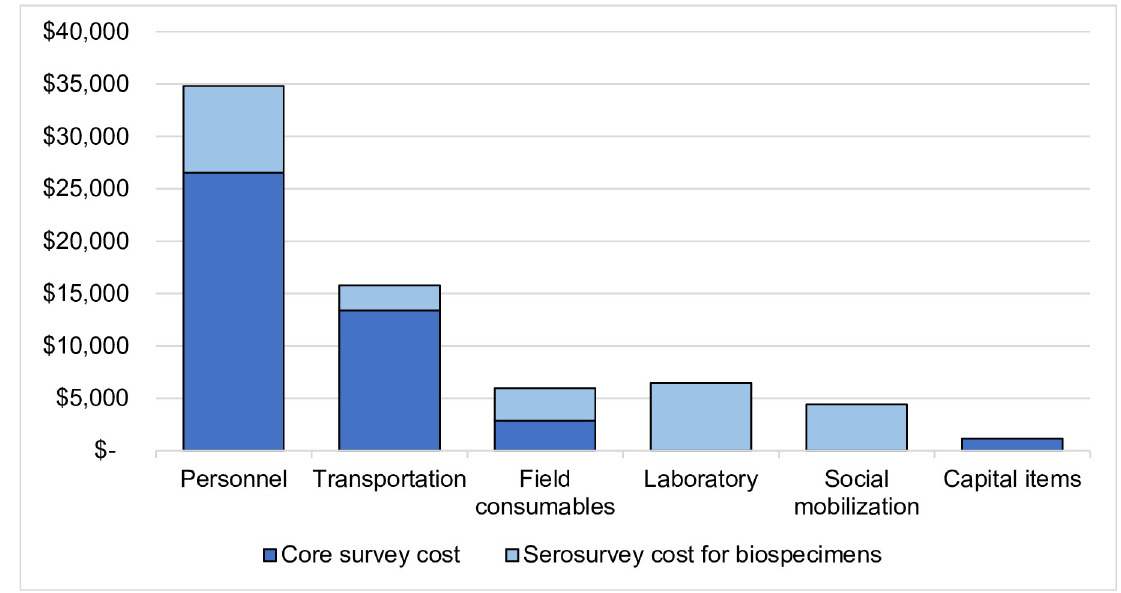
Fig 2. Costs for the post-campaign vaccine coverage survey and serosurvey in Southern Province, Zambia by input category. Costs captured for each input category span across serosurvey activities. Dark blue represents core survey costs that would be included in a vaccination coverage survey, while light blue represents the costs that are specifically attributable to a serosurvey due to blood specimen collection and testing, such as laboratory costs. All bars sum to the total cost of $68,558. All costs are in 2016 USD.